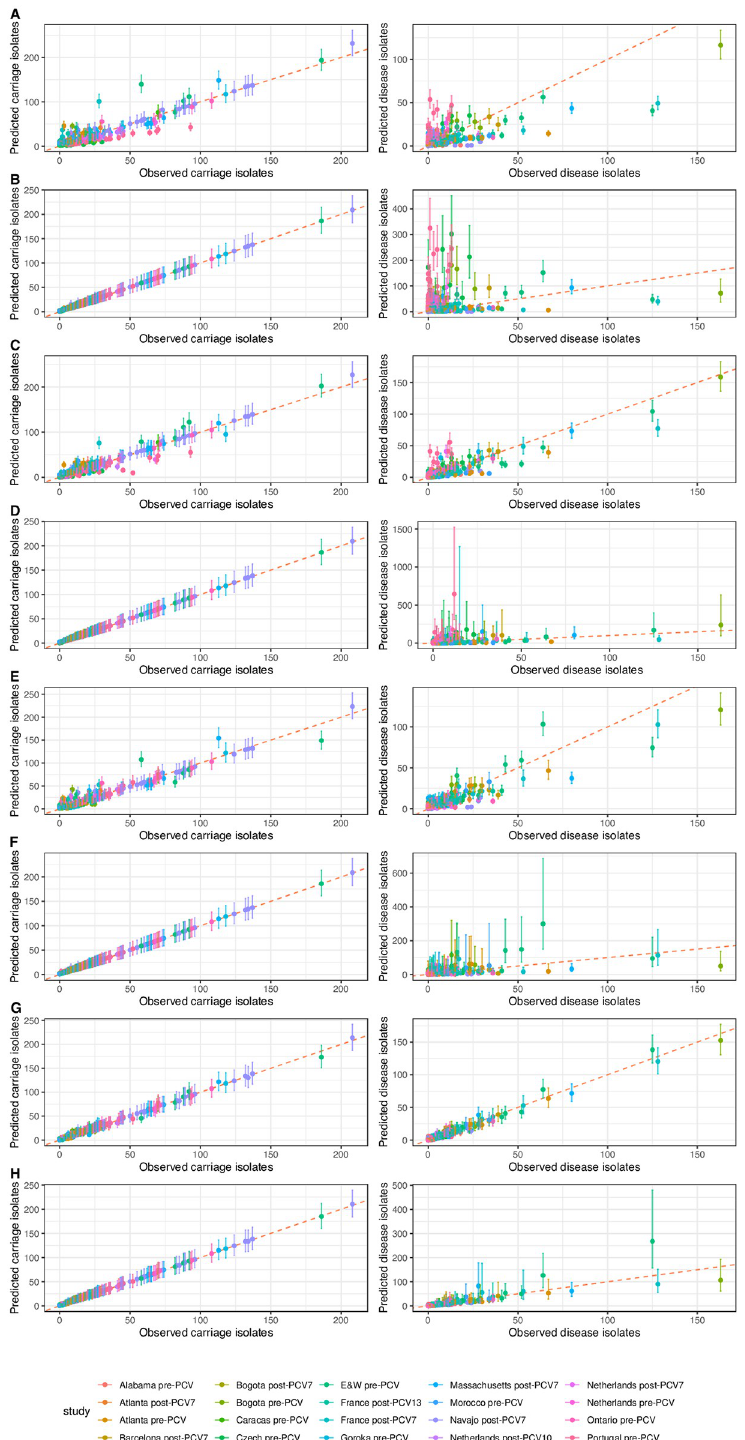
Fig 1. Comparison of observed and predicted counts of each serotype within each study of S . pneumoniae invasiveness in children. The points show the observed value on the horizontal axis, and the median predicted value on the vertical axis. The error bars show the 95% credibility intervals. The points and bars are coloured by the study to which they correspond; note that England and Wales is abbreviated to “E&W” (S1 Table). The red dashed line shows the line of identity, corresponding to a perfect match between prediction and observation. The left column shows